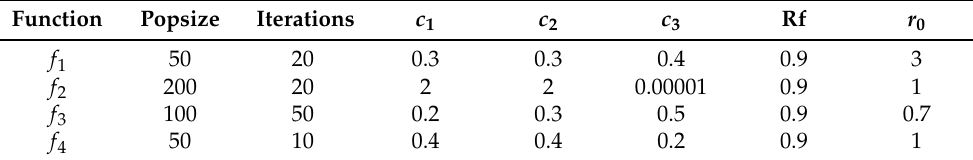
Table 4. Parameters setting. Function Popsize